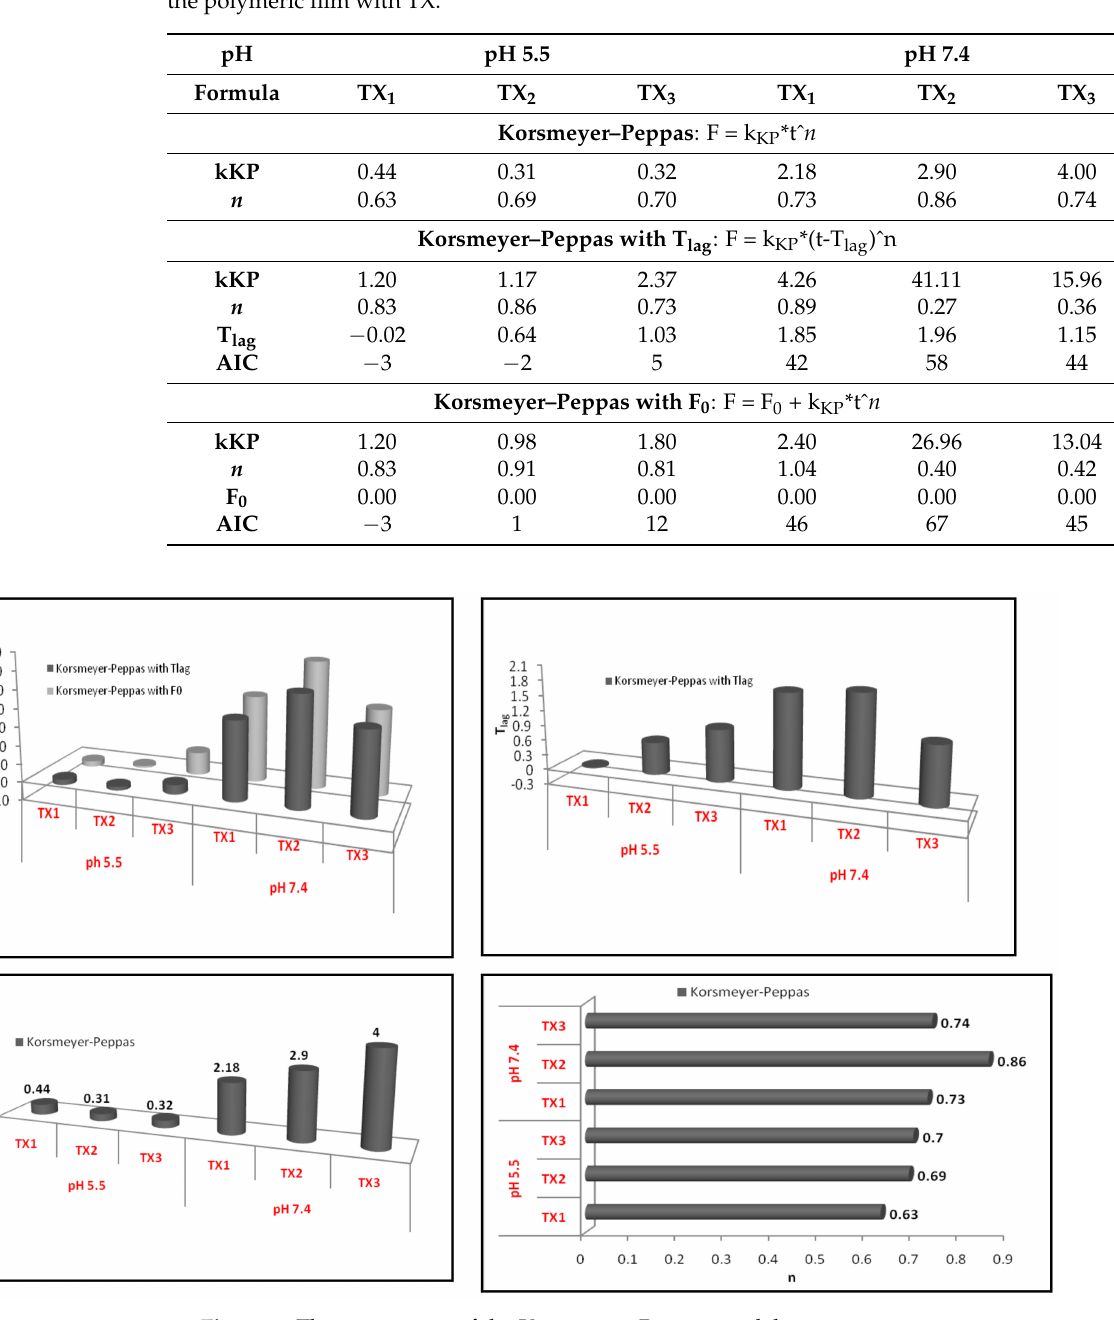
Figure 7. The parameters of the Korsmeyer–Peppas